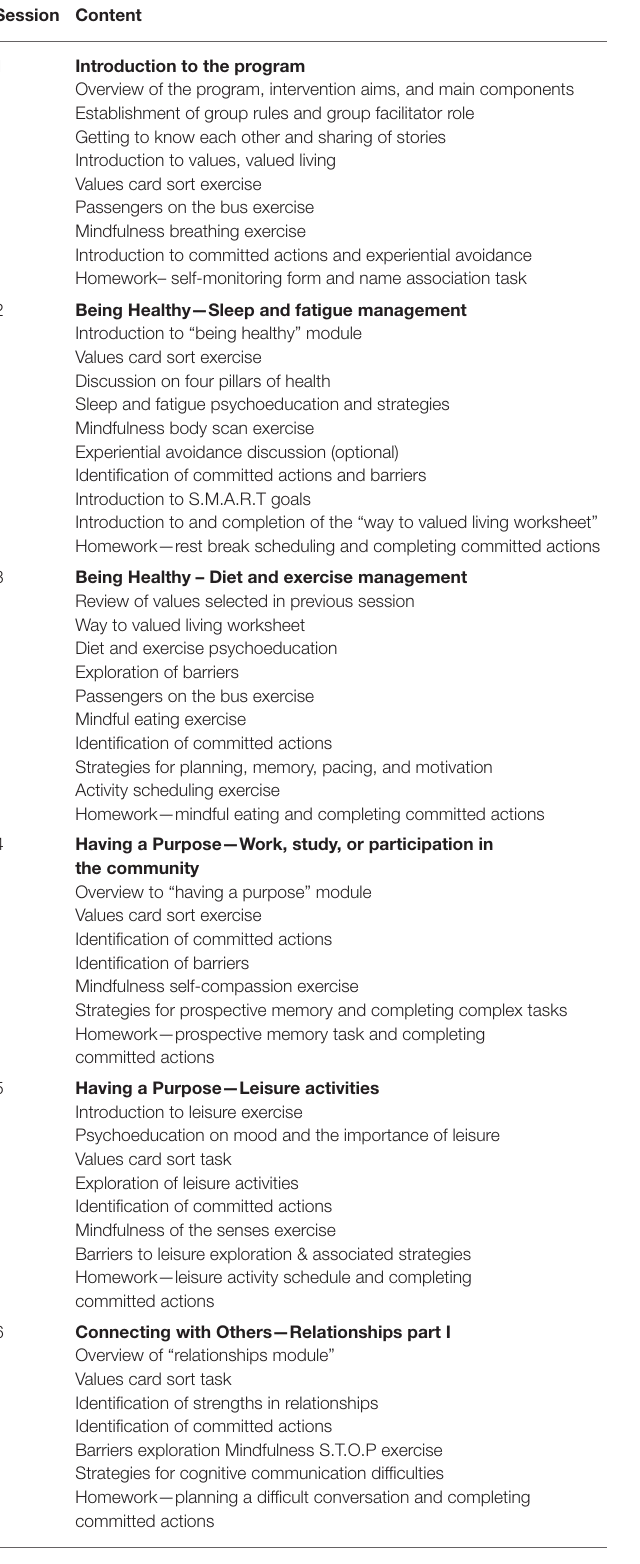
TABLE 2 | Overview of Valued Living after Neurological Trauma